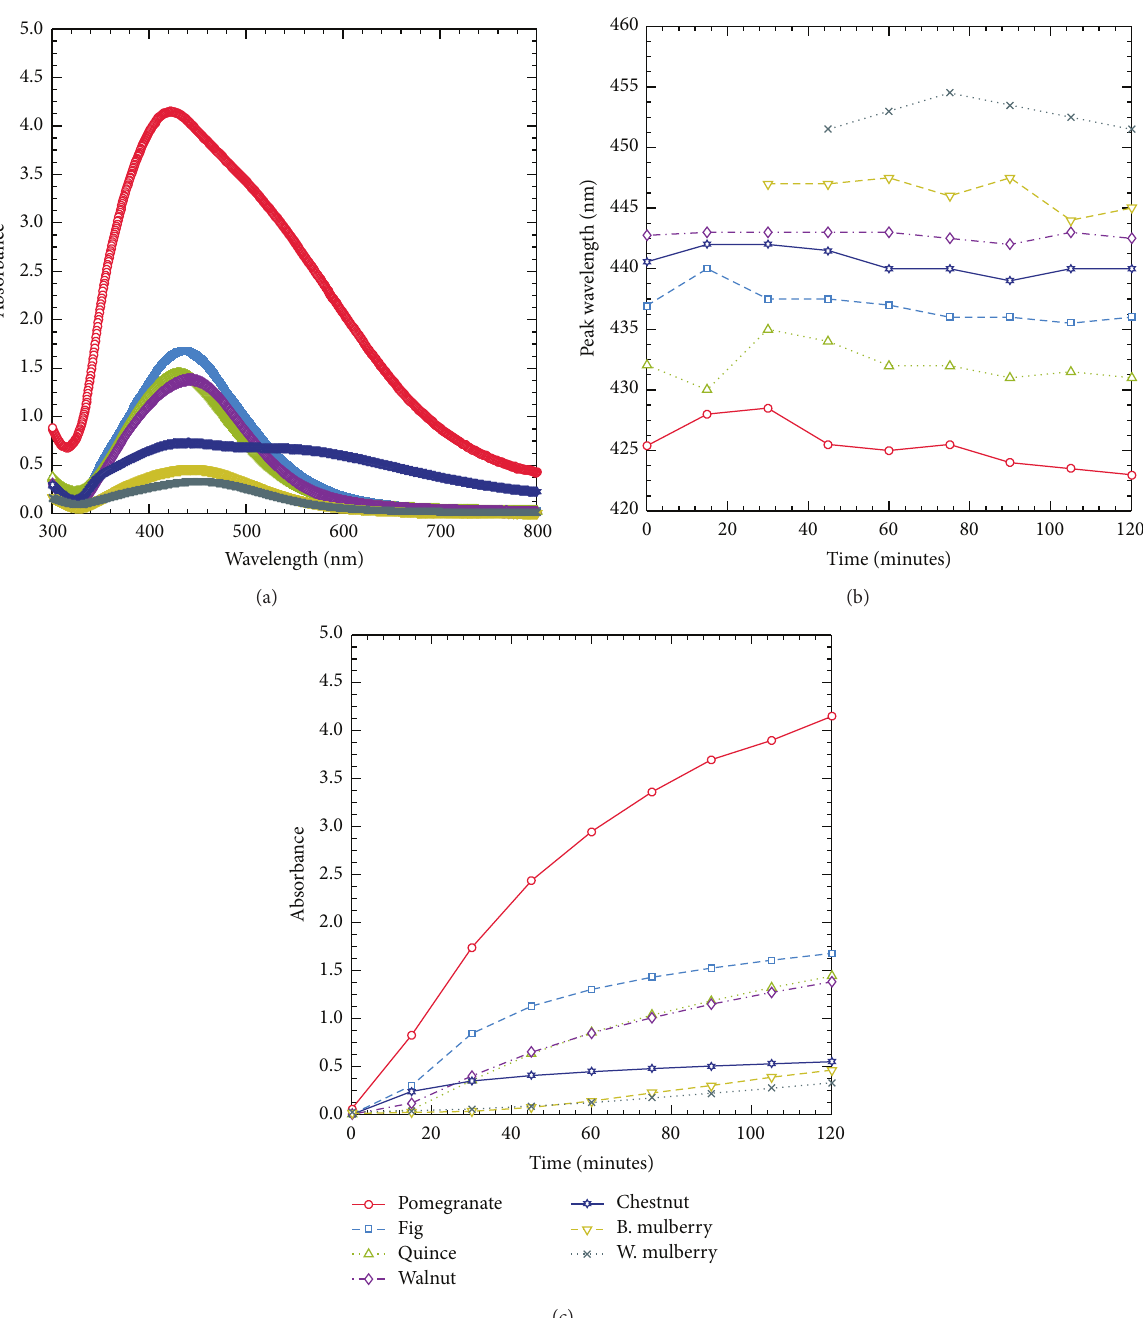
Figure 3: UV-Vis spectra of the mixtures of pomegranate, quince, chestnut, fig, walnut, mulberry leaf extracts, and 2mM AgNO 3 solutions recorded 120 minutes after the mixing (a). Time variations of SPR peak wavelengths (b) and peak absorbance (c) for the mixtures in